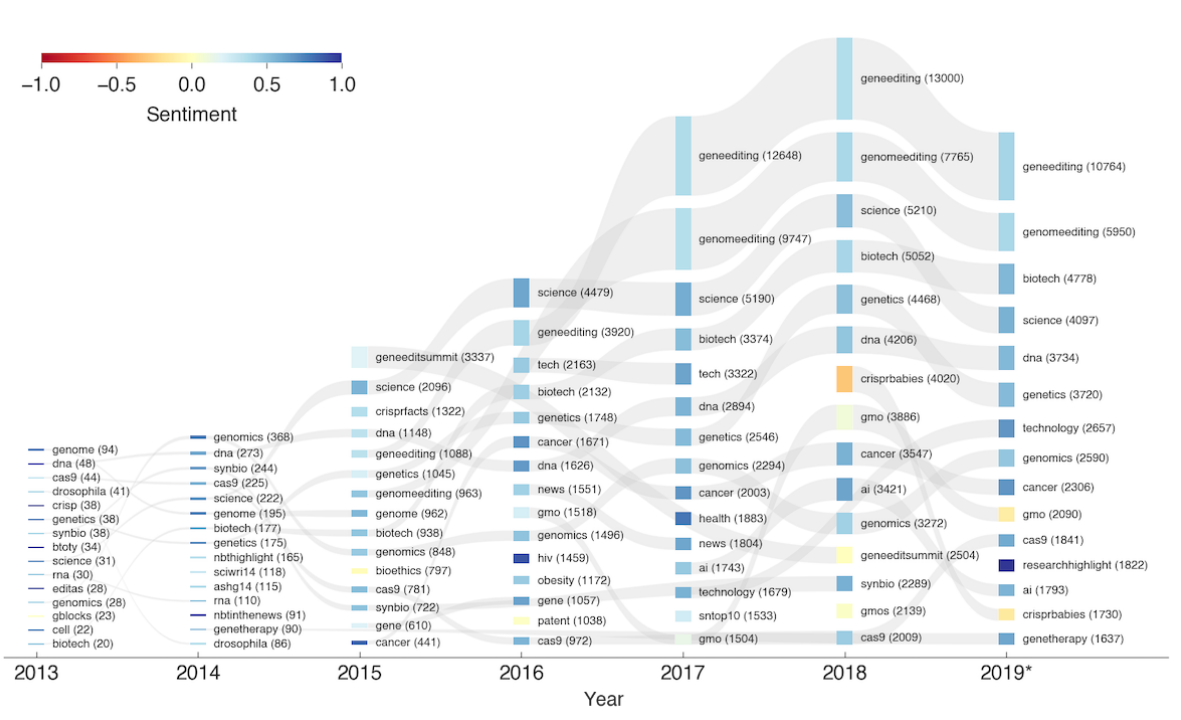
Figure 4. Visualization of the sentiment associated with the most frequently used hashtags every year. For every year, the 15 hashtags with the highest counts for that year are included (the hashtag #crispr was excluded). The hashtags are sorted by yearly counts (indicated by the bar height), where the hashtag with the highest count is at the top. The color represents the average sentiment for the respective hashtag, with blue representing a very positive sentiment and red representing a very negative sentiment. If a hashtag is listed in multiple years, the occurrences are linked with a gray band. The number of tweets with the hashtag is indicated in parentheses next to the respective hashtag. For the year 2019, the counts were extrapolated from the months before June to the full